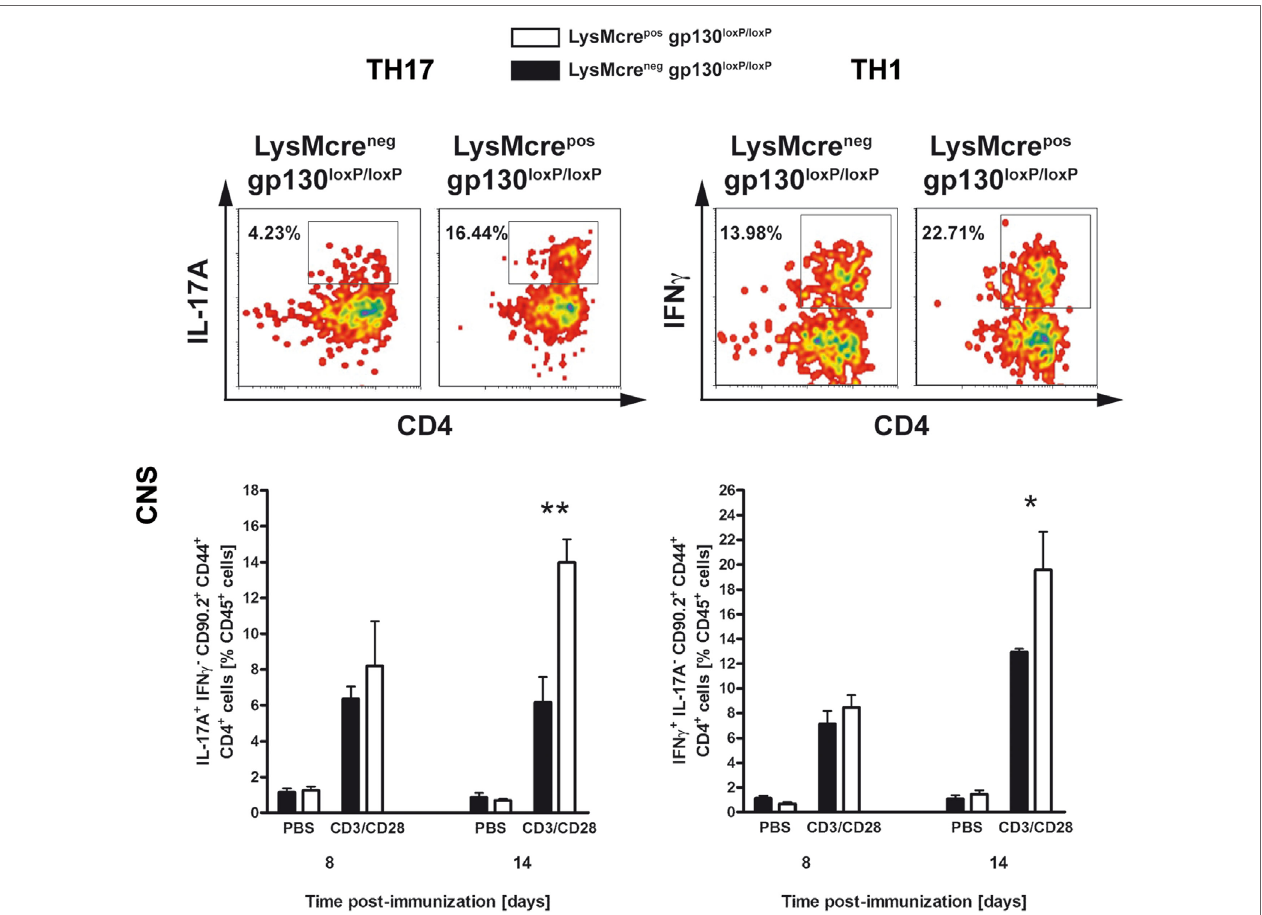
FigUre 7 | TH17 and TH1 immune responses in the CNS of immunized LysMcre pos gp130 loxP/loxP mice and LysMcre neg gp130 loxP/loxP littermates. During the course of EAE, the frequency of CNS-infiltrating TH17 and TH1 cells was determined by intracellular cytokine staining and subsequent flow cytometry. Analysis of intracellular IL-17A (left) and IFN γ production (right) by anti-CD3/CD28-stimulated cells is shown. For the analysis of TH17 and TH1 cells, single cell suspensions of CNS- infiltrating lymphocytes were performed at different time points (gated on CD90.2 + CD44 + CD4 + cells). Representative flow cytometry density plots of IL-17A- and IFN γ -producing cells isolated on day 14 are shown. Data represent means and SEs of five mice per group. One experiment representative out of three performed is shown. Statistical analysis was performed using Mann–Whitney test. Asterisks indicate statistical significance (* p ≤ 0.05; ** p ≤